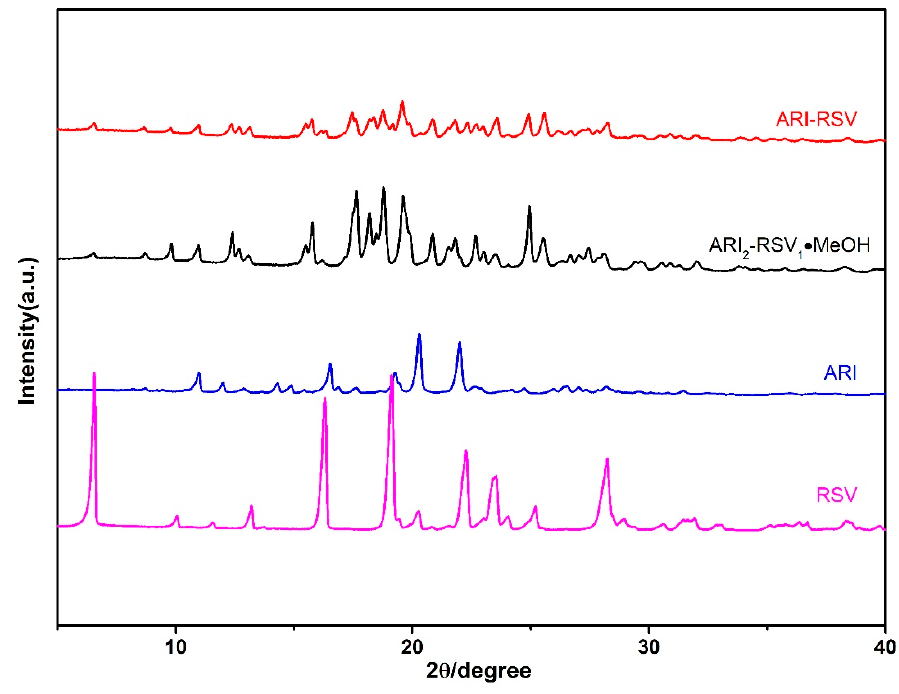
Figure 5. The PXRD pattern if ARI and RSV cocrystals.